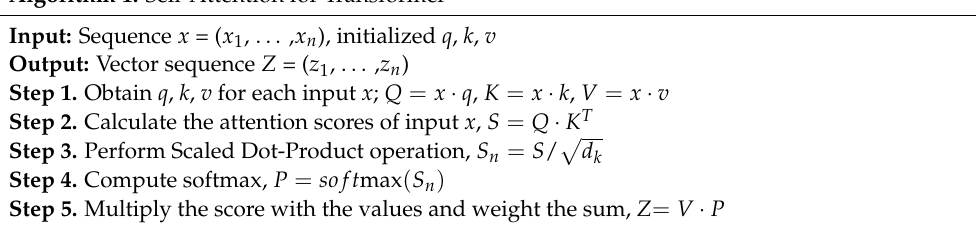
Algorithm 1: Self-Attention for Transformer